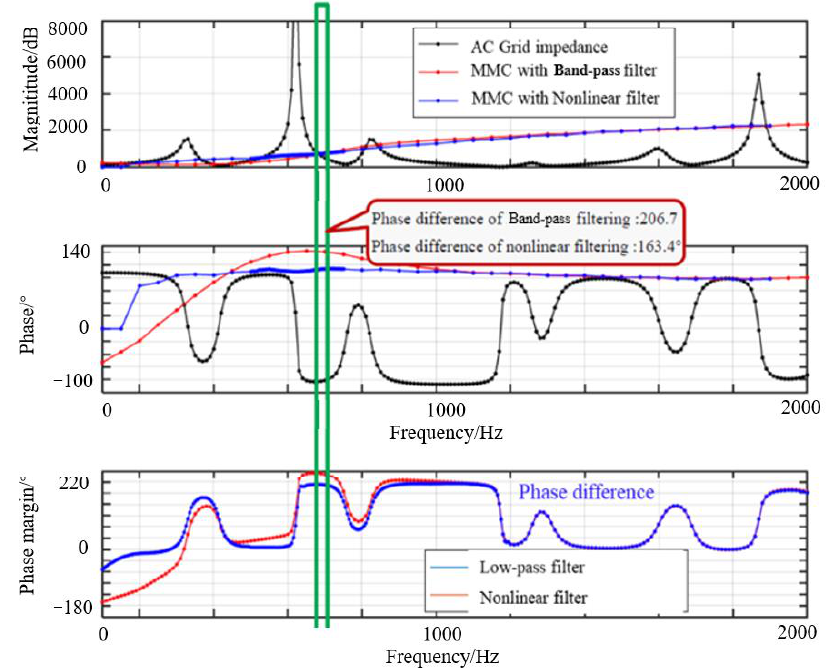
Figure 20. Stability analysis of MMC using different filters.